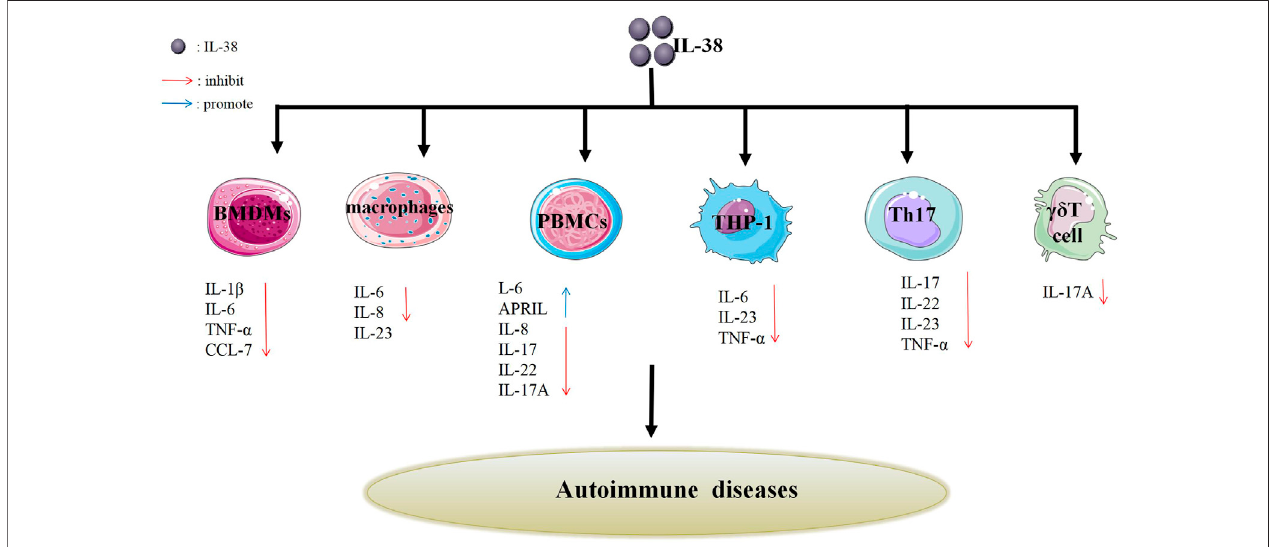
FIGURE 1 | Effects of IL-38 on different cells. IL-38 affects the secretion of different cells such as Th17 cells, γ δ T cells, PBMCs, BMDMs, macrophages, THP-1 cells,etc.,therebyinhibitingtheproductionofrelatedcytokines(IL-17,IL-22,IL-23,etc.)orpromotingtheproductionofrelatedcytokines(IL-6andAPRIL).Theinhibition or promotion effect may impact autoimmune